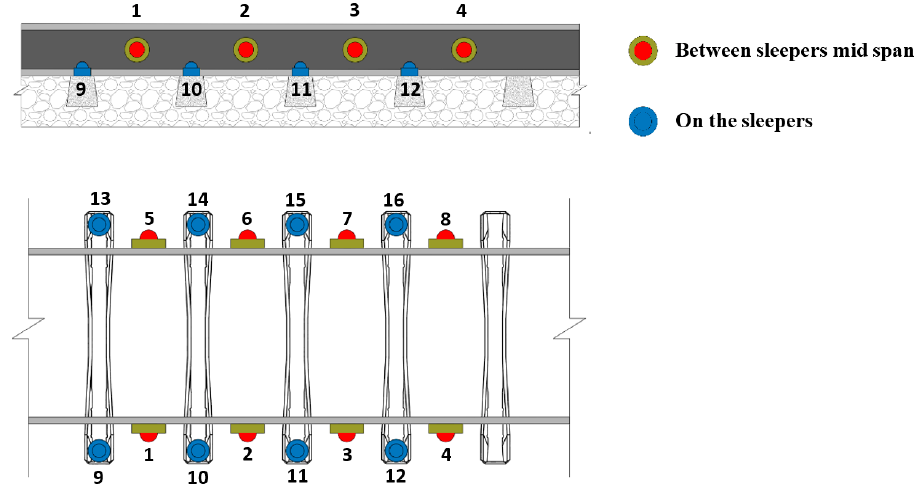
Figure 10. Virtual wayside monitoring system.